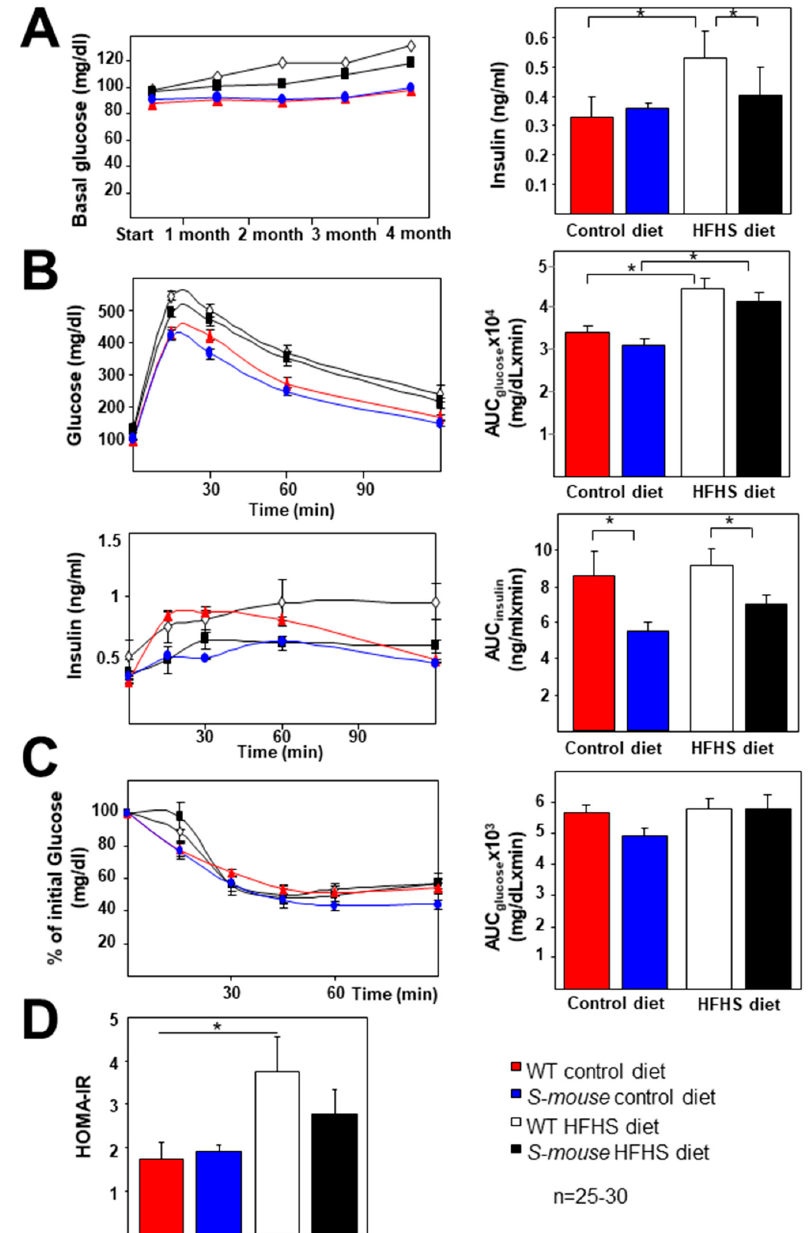
Figure 2. Glucose metabolism characterization under 16-week, high-fat, high-sucrose or control diet-fed WT and S-mice . ( A ) Evolution of fasting plasma glucose levels and insulin levels in all mice groups. ( B ) Plasmatic glucose levels during the GTT (top graph) and the area under the curve (AUC glucose ) determined from the glucose measurements of the test (right panel) in all mice groups. Plasmatic glucose-stimulated insulin levels during the GTT (lower graph) and the AUC insulin determined from the insulin measurements of the test (right panel). ( C ) Glucose levels (percentage relative to basal glucose levels) during ITT in 4 h-fasted mice. Statistical analysis was performed using one-way ANOVA. ( D ) HOMA-IR index in four groups of mice. * p ≤ 0.05. HFHS high-fat, high-sucrose, GTT glucose tolerance test, ITT insulin tolerance test, HOMA homeostasis model